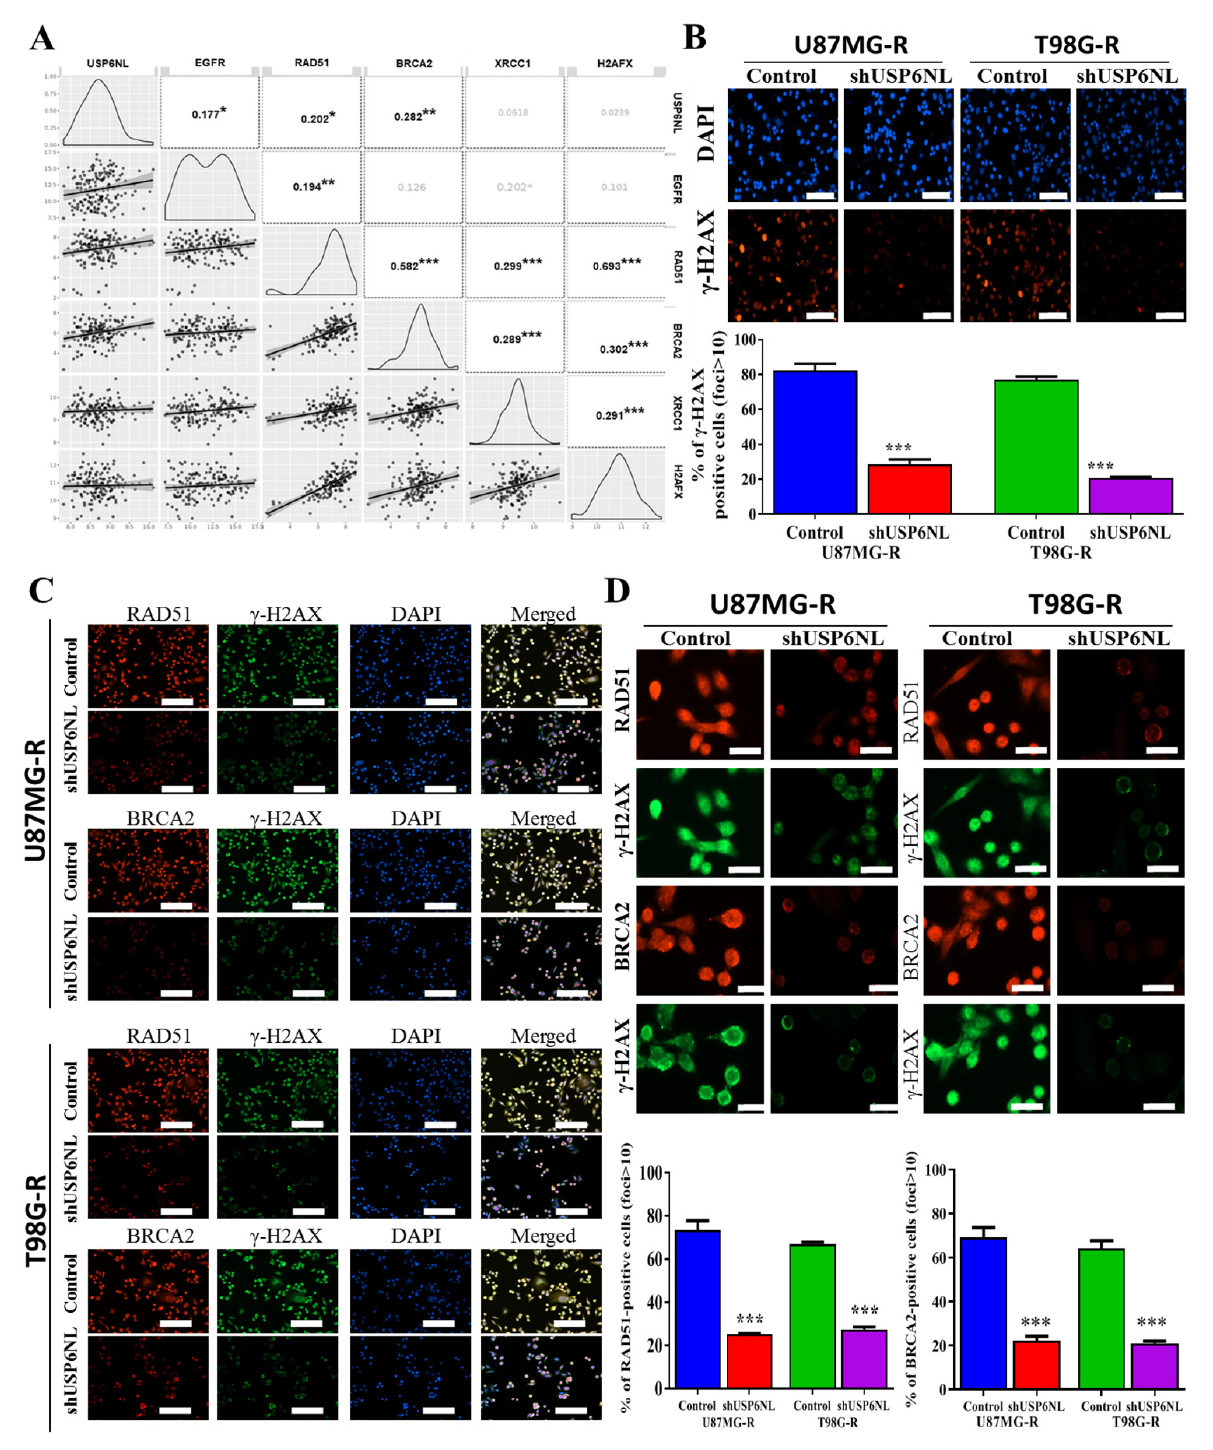
Figure 5. USP6NL regulates the DNA damage response. ( A ) Bioinformatics analysis of the correlation expression of USP6NL and EGFR (r 2 = 0.177), with DNA repair response (DDR) markers RAD51 (r 2 = 0.202) and BRCA2 (r 2 = 0.282). ( B , C ) Immunostaining with indicated antibodies. The representative image shows that USP6NL depletion inhibits DNA damage repair by inhibiting the expression of RAD51 and BRCA2-positive cells; scale bar: 10 µm ( D ) Representative images of RAD51/BRCA2 foci in USP6NL-knockdown cells. * p < 0.05, ** p < 0.01 and *** p < 0.001.